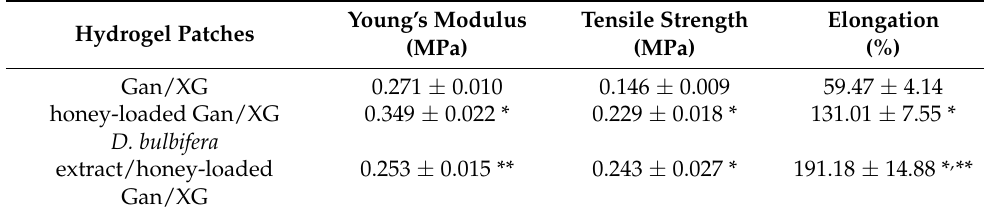
Table 4. Mechanical properties of the hydrogel